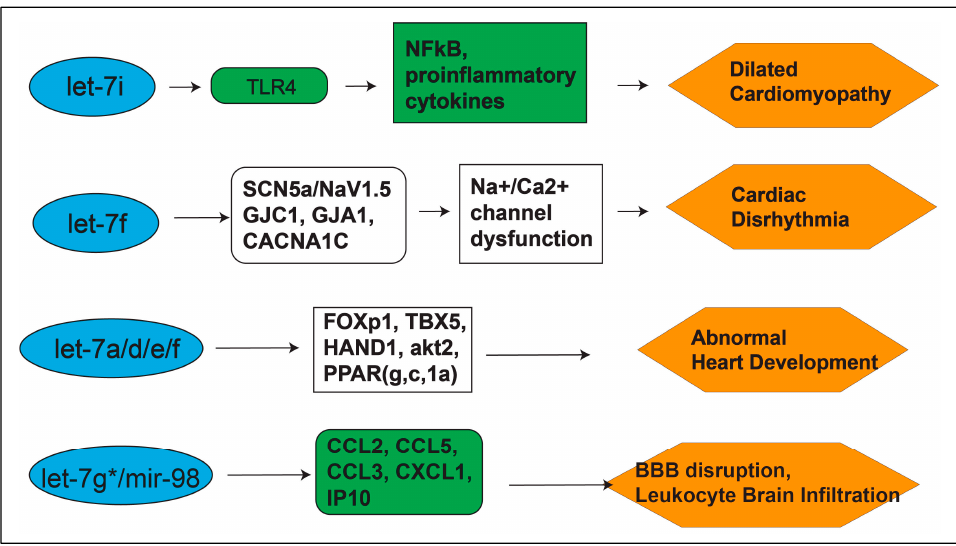
Figure 2. Targets of the let-7 miRs in cerebral and cardiovascular disease conditions . Green boxes show confirmed targets, while white boxes show bioinformatic prediction show confirmed targets, while white boxes show bioinformatic prediction [13,21,23–26,36,37]